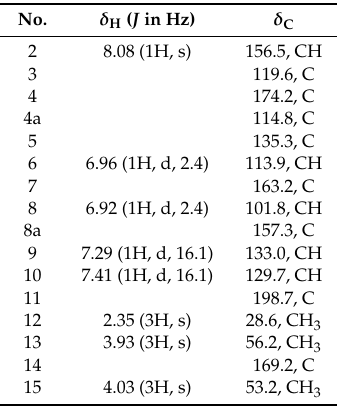
Table 2. 1 H-NMR (600 MHz) and 13 C-NMR (150 MHz) data for 2 in CDCl 3